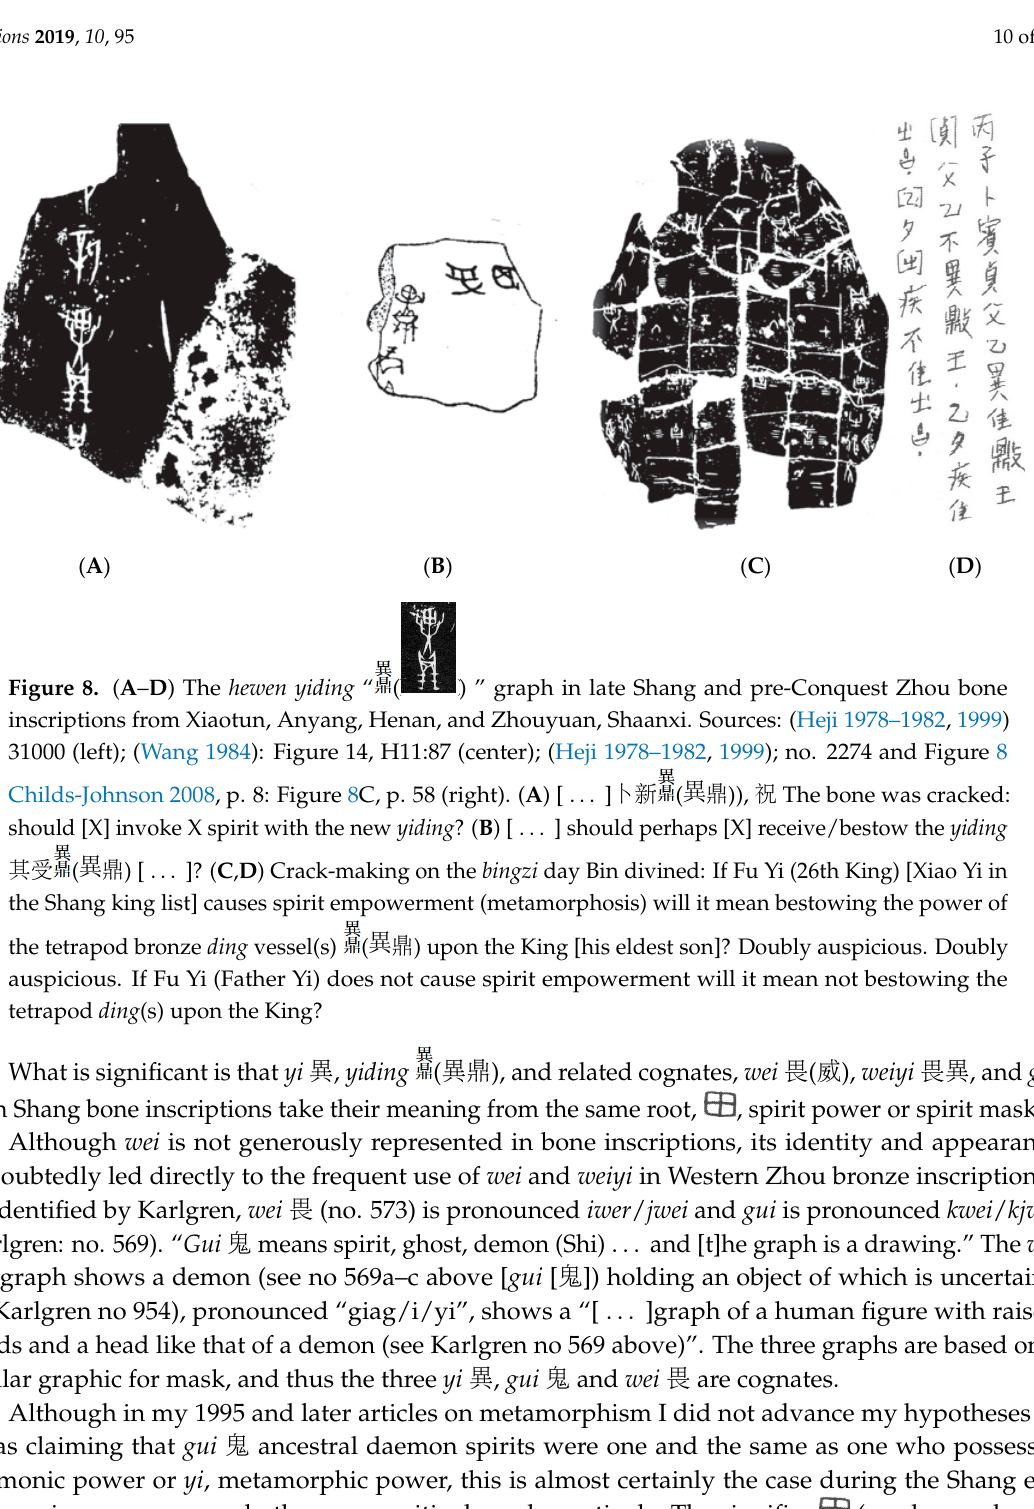
Figure 1. Masked semi-human figures with arms raised. ( A ) Yi 異 graph; ( B ) Displayed yi image, probably Kui; ( C ) Simplified displayed yi